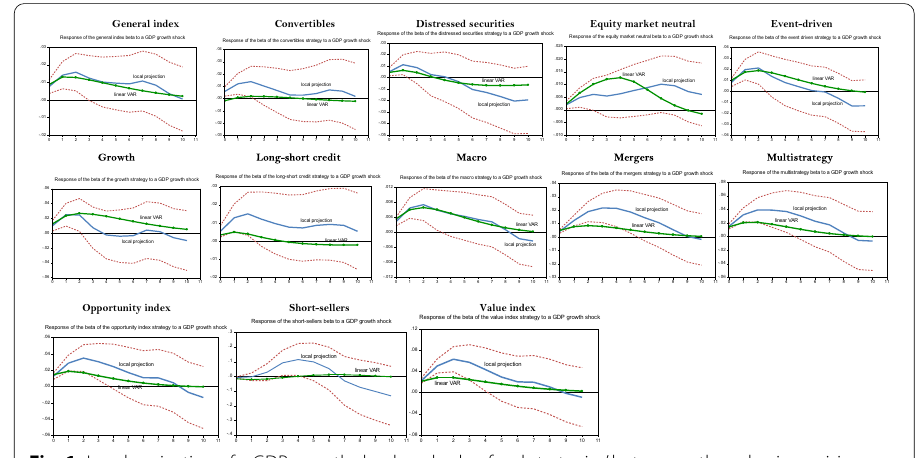
Fig. 1 Local projection of a GDP growth shock on hedge fund strategies’ betas over the subprime crisis. Notes: The impulse response functions corresponding to the linear LP—i.e., the beta forecast following external shocks—are built using the Jordà’s (2004, 2005, 2009) algorithm provided by Eren Ocakverdi, consultant at Yapy Kredi. The local projection of a beta strategy is performed over the subprime crisis (2007Q3–2009Q4). We also provide the linear VAR estimated over the whole sample period selected as benchmark. The confidence interval of the LP impulses, computed at the threshold of 95%, is in dotted lines. As explained in the paper, our model comprises five endogenous shocks, placed in the following order to perform the Cholesky factorization (Sims 1980) required to build structural shocks: GDP growth, term spread, credit spread, beta (own shock) and VIX. As usual, these variables are ordered by increasing level of endogeneity. This order relies on the conventional information criteria: Akaike and Schwartz criteria. Only strategies whose impulse response functions are significant at a level of 10% or less are reported in this table. Note that the IRFs are computed for positive GDP shocks but the corresponding IRFs associated with negative shocks are the mirror images of the former since, for both methods, the IRFs being computed with linear techniques. The fixed income and futures strategies are excluded since their IRFs are not